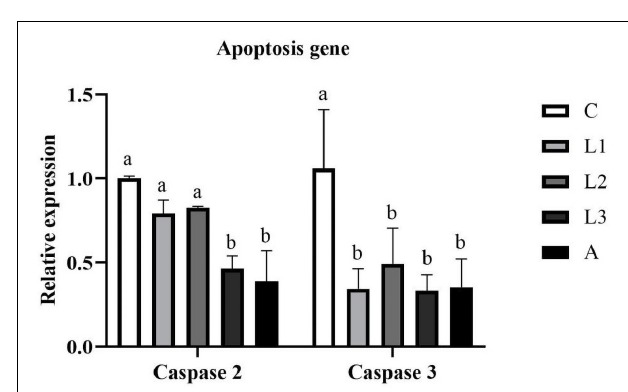
FIGURE 2 | Hepatopancreas RNA expression level of anti-inflammatory genes of L. vannamei fed diet supplementation with/without lutein or astaxanthin for 56 days.